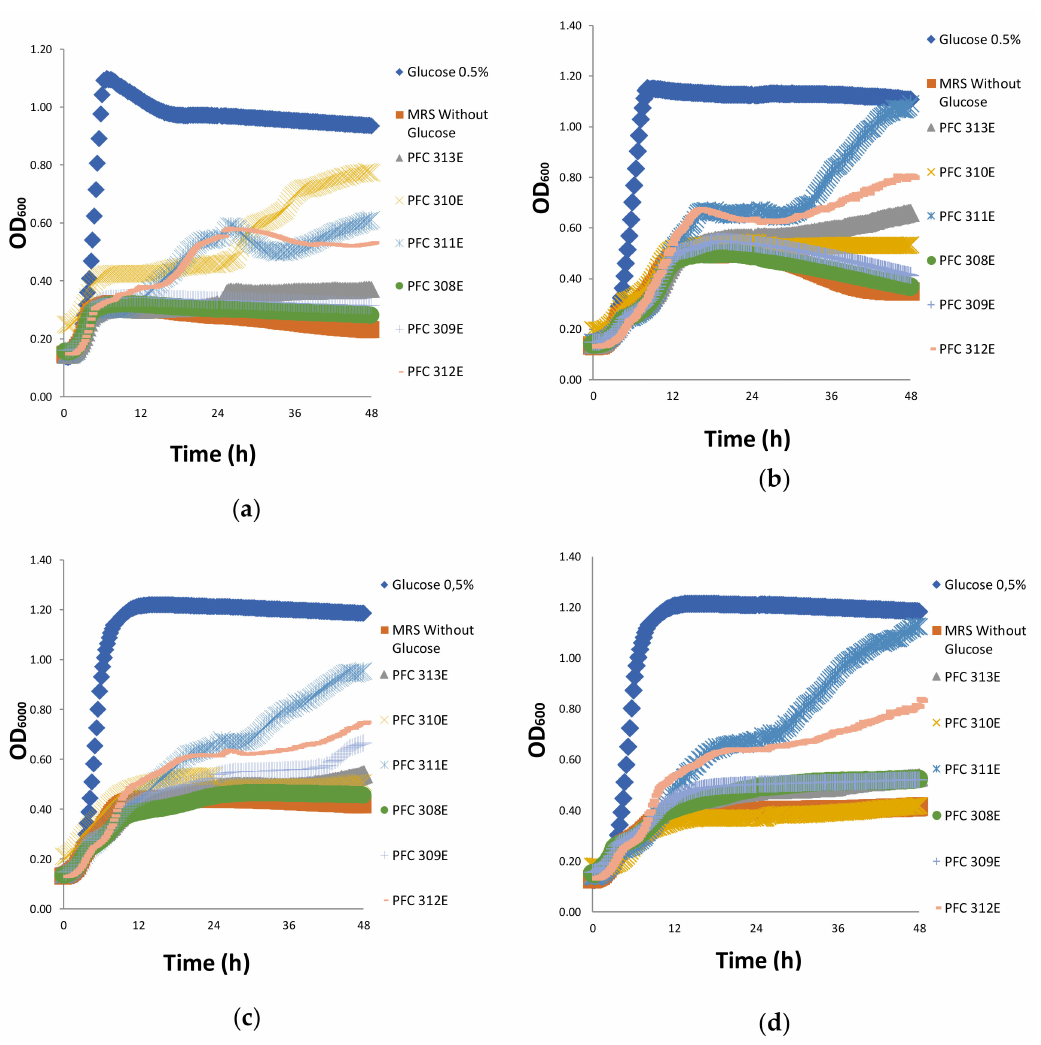
Figure 2. The growth curve of probiotic strains ( a ) B. bifidum DSM 20082, ( b ) L. casei subsp. shirota, ( c ) L. rhamnosus GG and ( d ) L. acidophilus DSM 20079 with EPS and